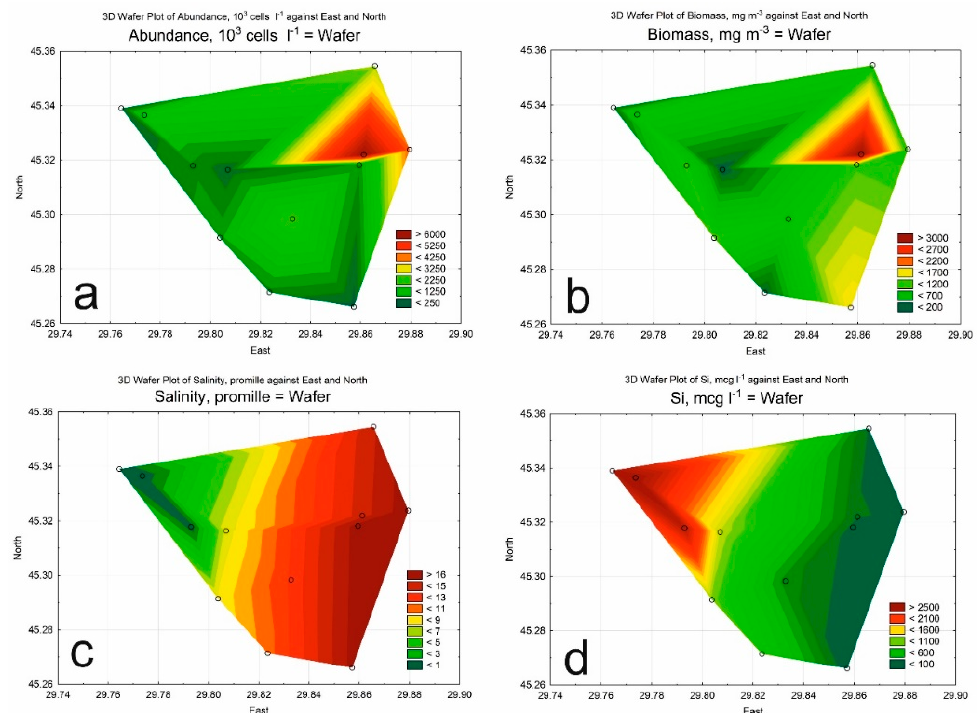
Figure 2. Statistically generated maps of phytoplankton (abundance ( a ), biomass ( b )) and hydro- logical and chemical parameters of water (salinity ( c ), silicium ( d )) on the surface horizon in the Ukrainian part of the Danube nearshore area in August 2018.